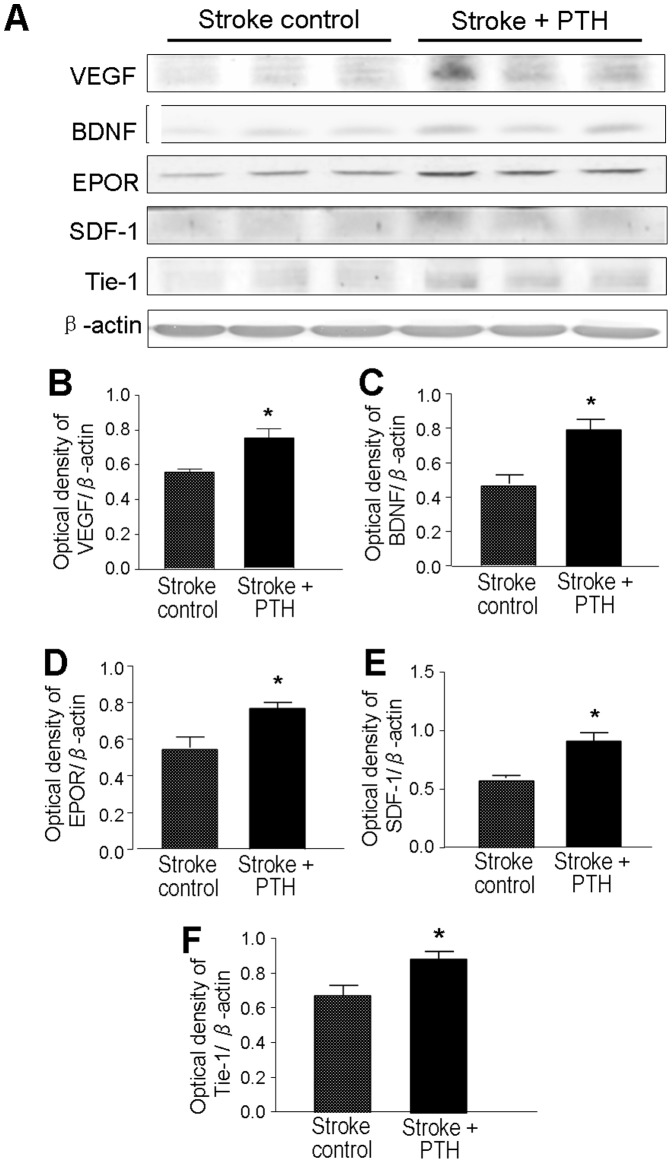
Effects of PTH on the expression of angiogenic and neurotrophic factors.The expression of key pro-regenerative factors in the peri-infarct region was detected using Western blot analysis. A. Electrophoresis gels show the protein levels of VEGF, BDNF, EPOR, SDF-1, and Tie-1 in the ischemic peri-infarct region in different animals 6 days after stroke. B to F. Densitometry analysis of the expression of BDNF (B), VEGF (C), EPOR (D), SDF-1 (E), and Tie-1 (F). Gray intensity was normalized against β-actin and quantified. PTH treatment significantly enhanced the expression of all these factors shown in A, compared with the stroke-saline group. N = 3 animals for each test; * P<0.05.